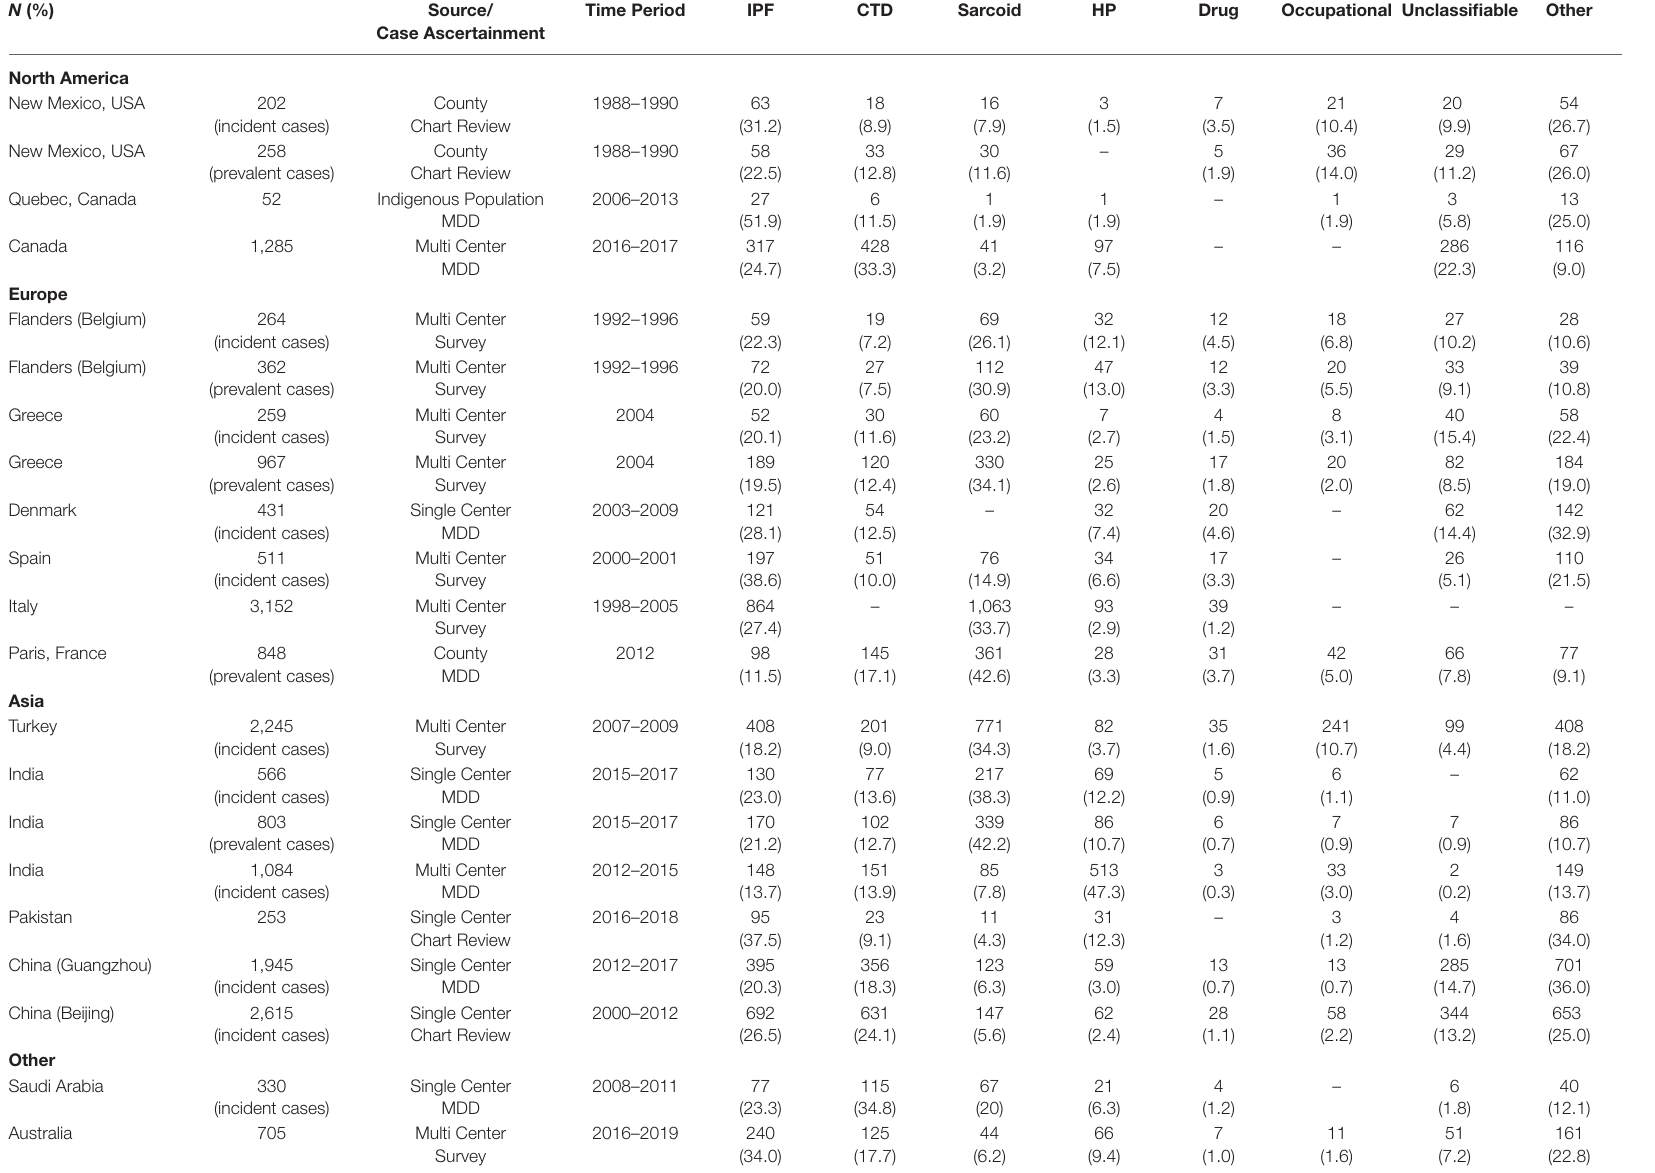
TABLE 2 | Relative frequency of interstitial lung disease